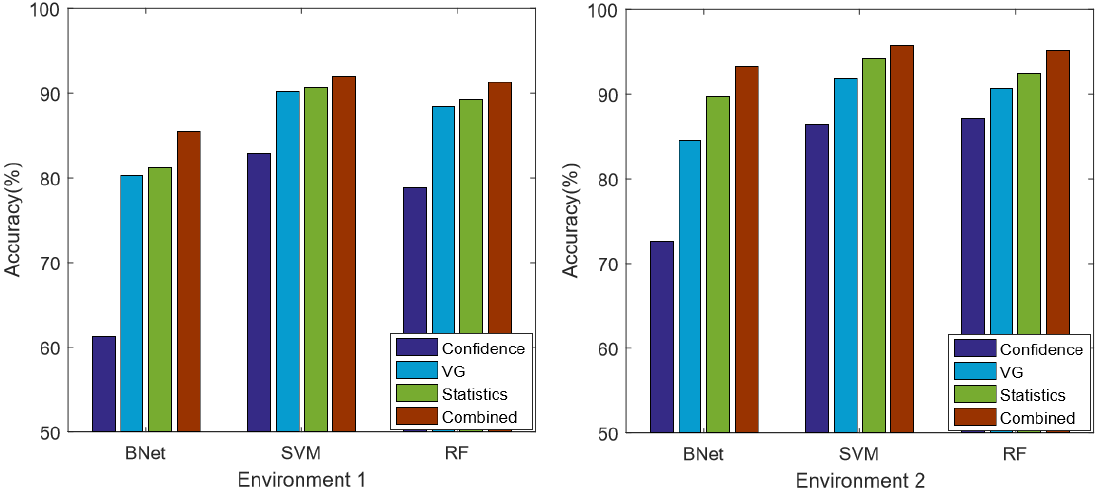
Figure 7. The comparison